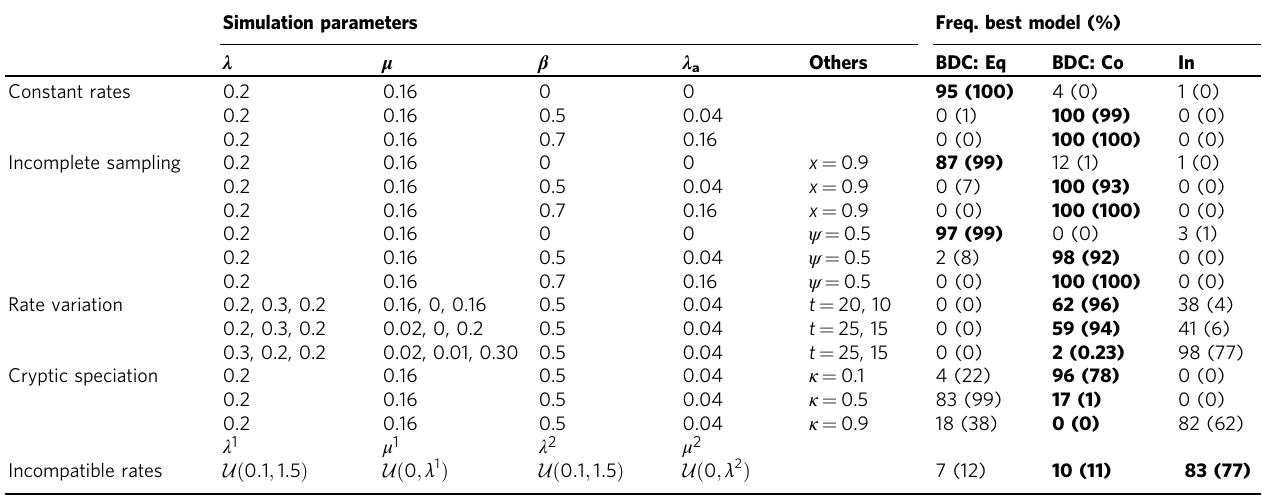
We simulated100data sets(fossils and phylogenies) under each setting(for more details,see Methods)and tested the fi t of models withequal (Eq),compatible(Co), and incompatible(In) rates using maximum likelihood. We calculated the frequencies with which each model was selected as the best one. We considered the best- fi t model to be the simplest model not rejected by the likelihood ratio test, with a signi fi cance threshold of 0.95 (results at the 0.99 threshold are shown in parentheses). Values in bold indicate the frequency with which the correct model was selected. We indicate with x the fraction of lineagesrandomly removedfrom the fossilrecord inthe incompletesamplingsimulations andwith ψ the Poissonsamplingrate used tosimulatefossil occurrences; t indicates the times of rate shifts in the simulations with rate variation; κ indicates the probability that speciation events are treated as cryptic, i.e. the new species cannot be distinguished from its parent species in the fossil record. Incompatible rates were generated by simulating independent birth − death trees for phylogenetic and stratigraphic data sets with random speciation and extinction